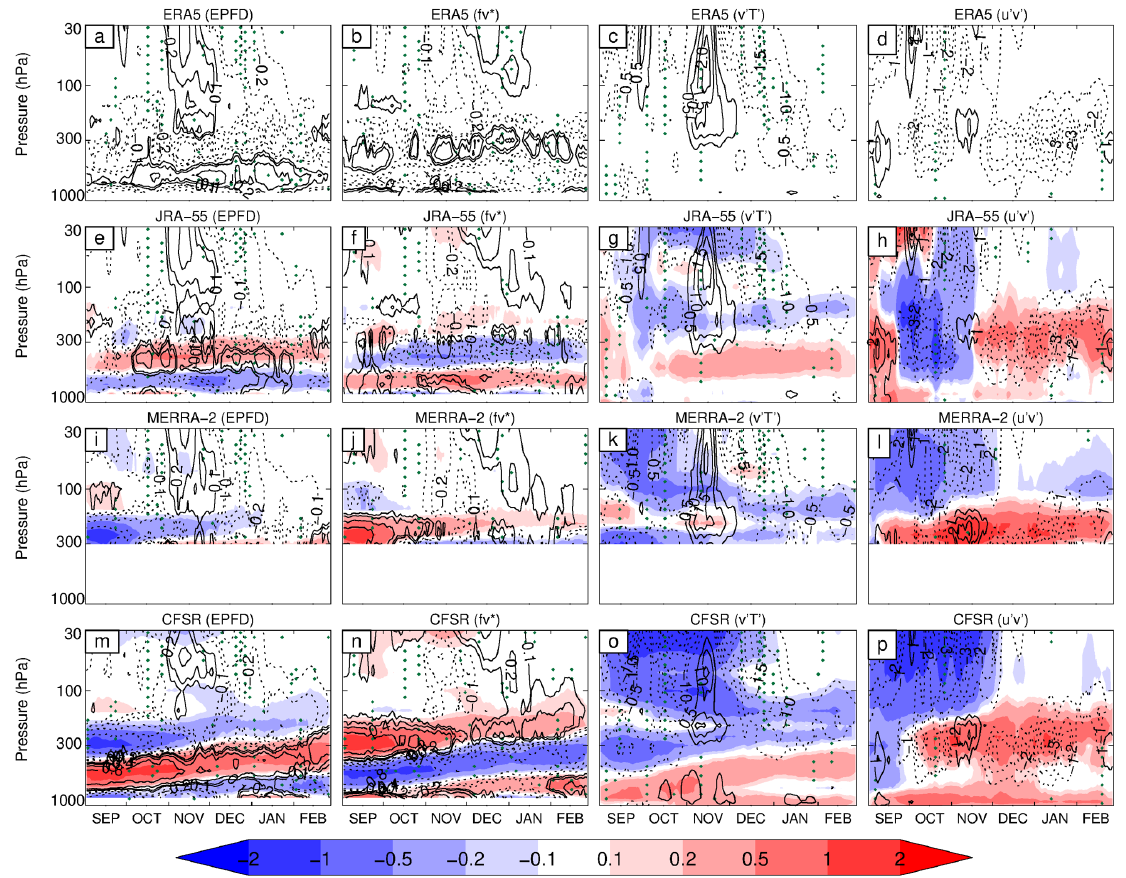
Figure 4. Time–height cross section of the trends in EP flux divergence EPFD (contour units: ± 0.1, ± 0.2, ± 0.4, and ± 0.8ms − 1 d − 1 per decade; first column), Coriolis torque f v ∗ (contour units: ± 0.1, ± 0.2, ± 0.4, and ± 0.8ms − 1 d − 1 per decade; second column), eddy heat flux v (cid:48) T (cid:48) (contour units: ± 0.5, ± 1.0, ± 1.5, ± 2.0, ± 2.5, and ± 3.0ms − 1 K per decade; third column), and eddy momentum flux u (cid:48) v (cid:48) (contour units: ± 1, ± 2, ± 3, ± 4, and ± 5m 2 s − 2 per decade; fourth column) averaged over 40 to 80 ◦ S from 1980 to 2001 for ERA5 (a, b, c, d) , JRA-55 (e, f, g, h) , MERRA-2 (i, j, k, l) , and CFSR (m, n, o, p) . The shading represents differences from ERA5 at intervals of ± 0.1, ± 0.2, ± 0.5, ± 1.0, and ± 2.0. Results in the range 300 to 1000hPa are not included in panels (i) , (j) , (k) , and (l) . Stippling denotes regions where the trends are significant at the 5% significance level. Note that for each panel the time series is